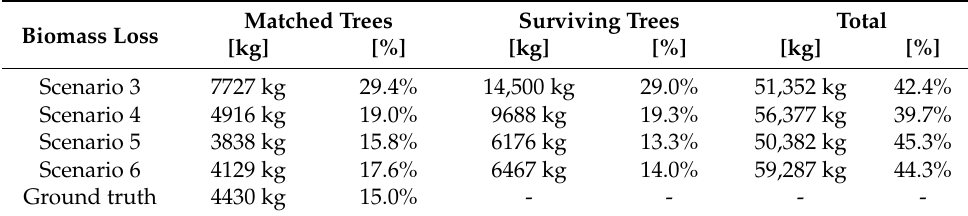
Table 5. The biomass loss estimates of the matched trees, surviving trees, and the complete area in the study area in different scenarios. Matched Trees Surviving Trees Total Biomass Loss [kg] [%] [kg] [%] [%] Scenario